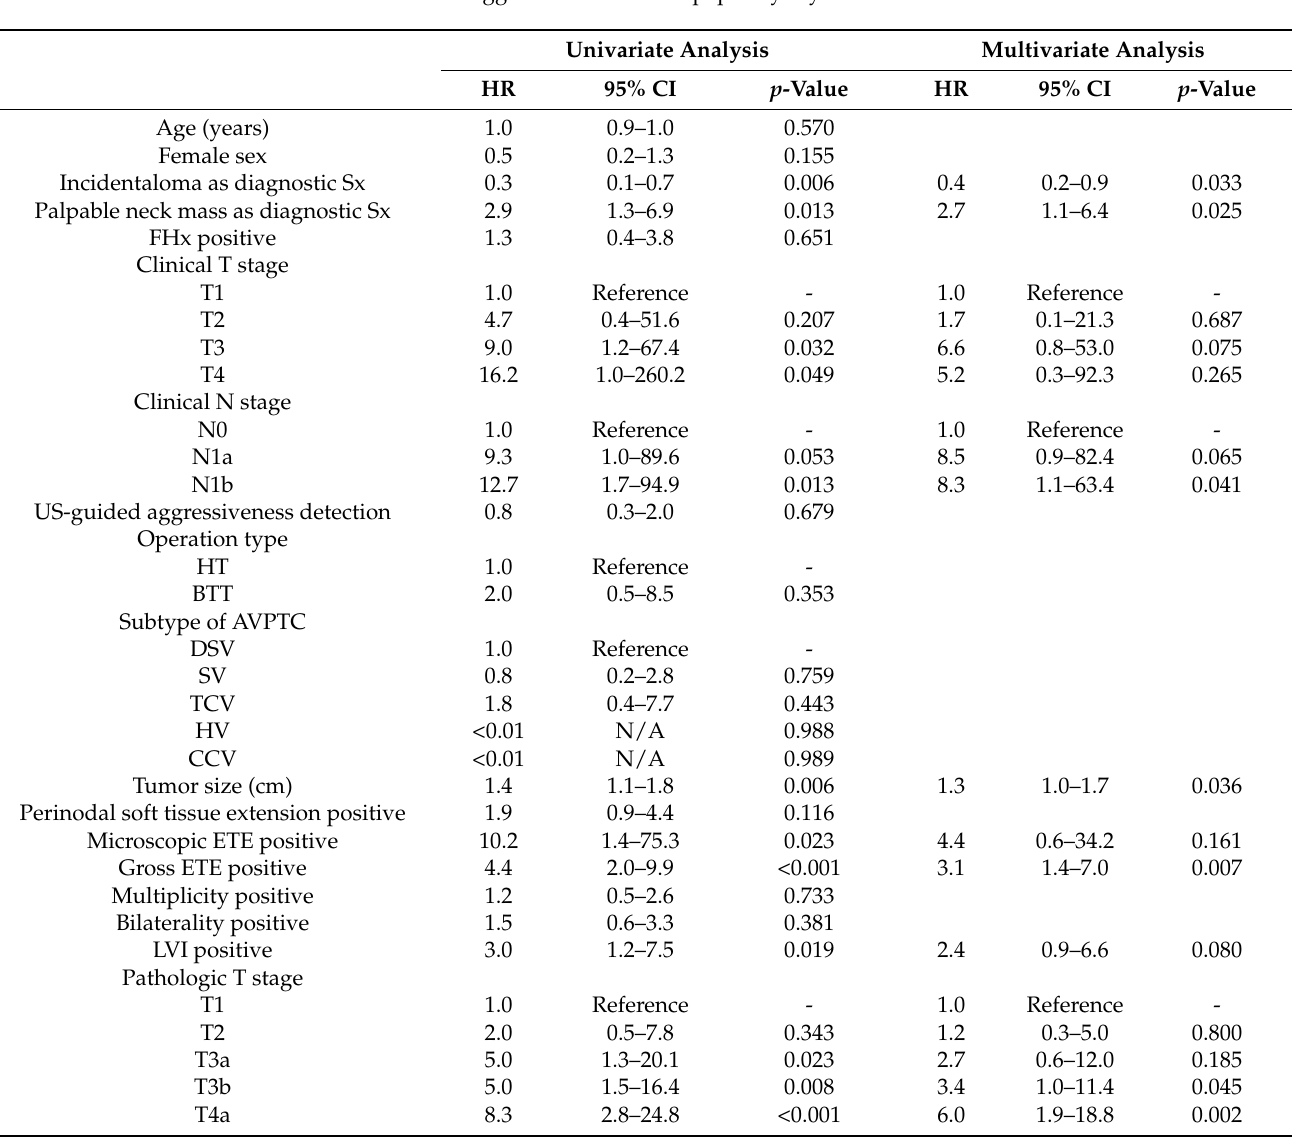
Table 5. Univariate and multivariate Cox regression analysis results for clinical characteristics, clinical image staging, initial pathologic findings, operation type, and adjuvant treatment factors in relation to recurrence of aggressive variants of papillary thyroid